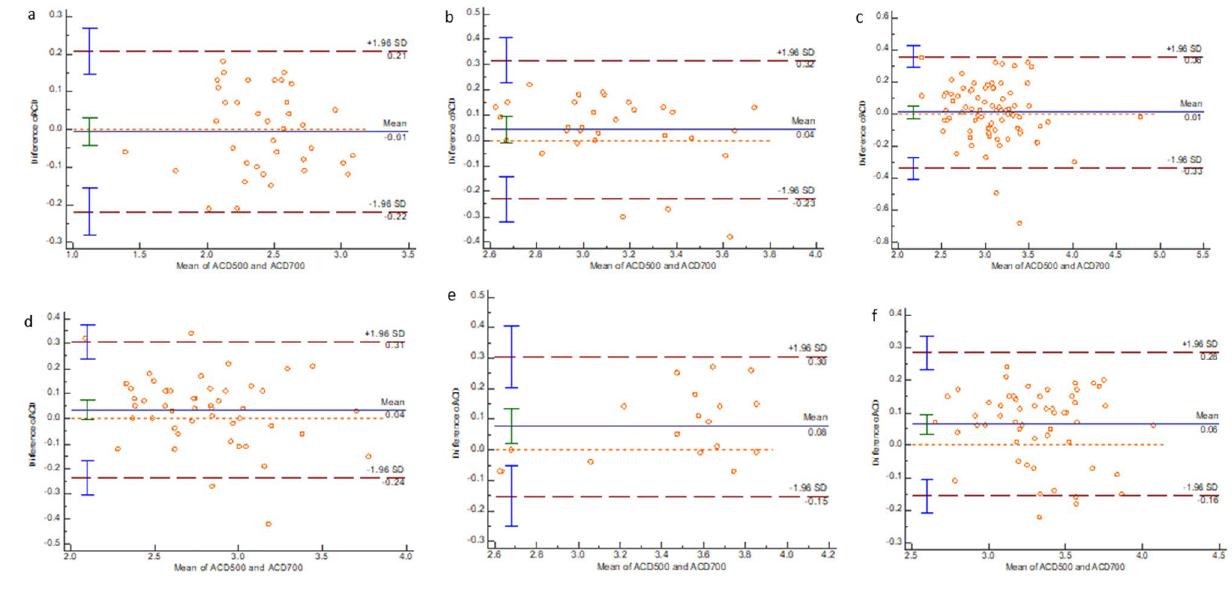
Figure 3. Bland–Altman plot showing the results of ACD measurement by the two instruments. ( a ) AL < 22.00 mm group. ( b ) 22.00 mm ≤ AL < 23.00 mm group. ( c ) 23.00 mm ≤ AL < 24.00 mm group. ( d )